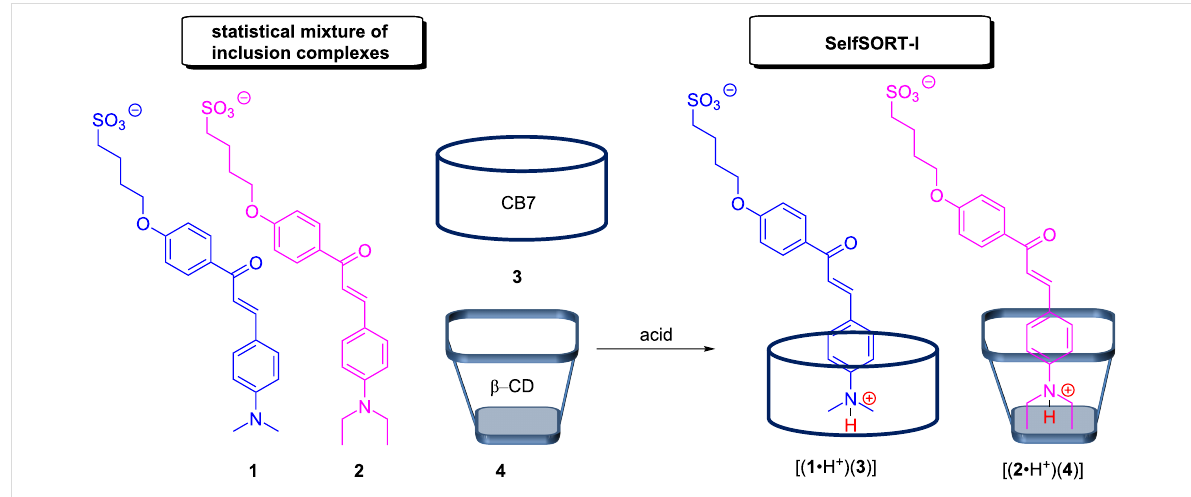
Figure 3: The pH-driven four-component 2-fold completive self-sorting based on host–guest chemistry.